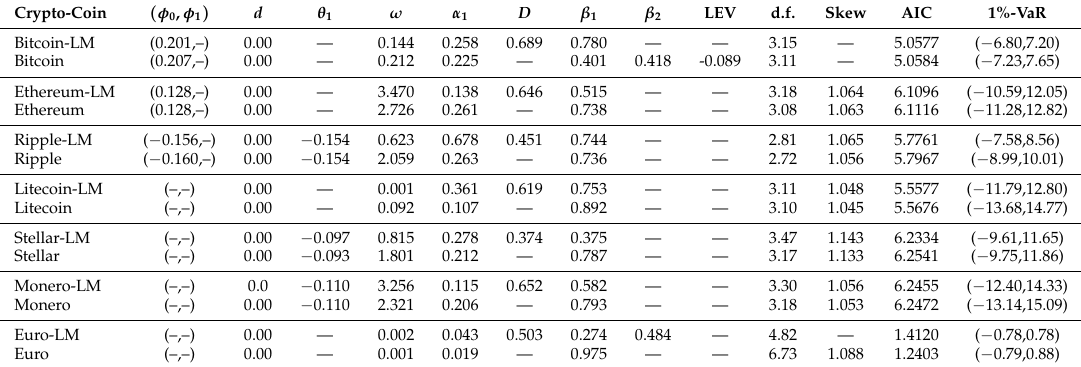
Table 3. Summary of the results from the ARFIMA ( p , d , q ) -FIGARCH ( m , D , s ) fits for all series. All parameters estimates are 5% statistically significant. Notations: LEV: leverage parameter; d.f.: degrees of freedom of the F distribution; skew: skewness estimate of the skew-t